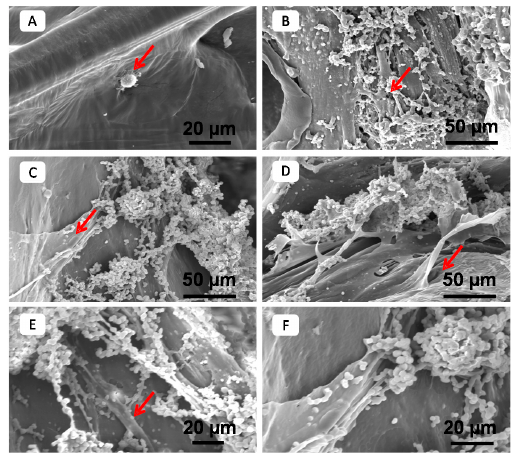
Figure 3. Images of cells cultured on ( a ) PCL scaffold; and ( b – f ) PCL/elastin composites. Top surfaces are shown in ( a ) and ( c ), cross sections in ( b ) and ( d – f ), arrowheads in the images show representative cells 50 mg/mL elastin solution was used to form composites. Figure reproduced from [209], with permission from Elsevier.